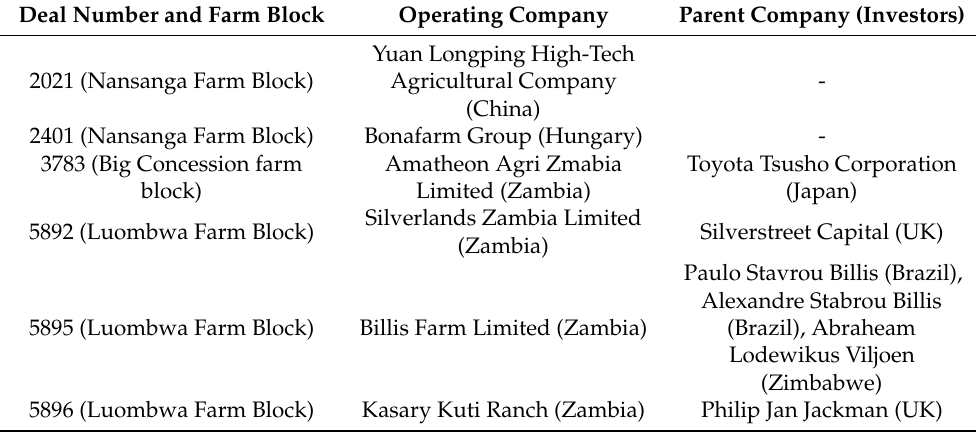
Table 5. Land Deals Connected to FBDP and Operating Companies and Investors [11]. Deal Number and Farm Block Operating Company Parent Company (Investors) 2021 (Nansanga Farm